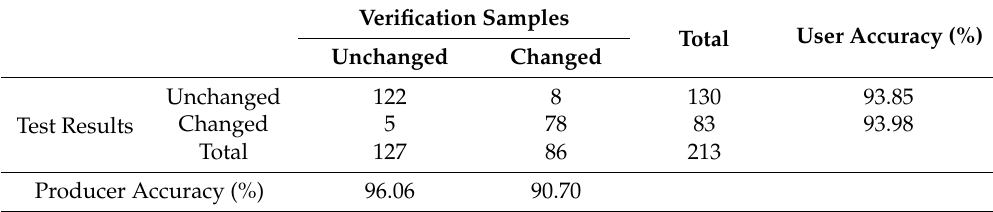
Figure 18. Examples of typical land cover change types: ( a(1) , b(1) , c(1) , d(1) , e(1) ): Worldview 02 Images in 2016: ( a(2) , b(2) , c(2) , d(2) , e(2) ): Worldview 02 Images in 2017: ( a(3) , b(3) , c(3) , d(3) , e(3) ): land cover change detection result using GF-1 images. Table 6. Confusion matrix for the maximum Kappa coefficient of the